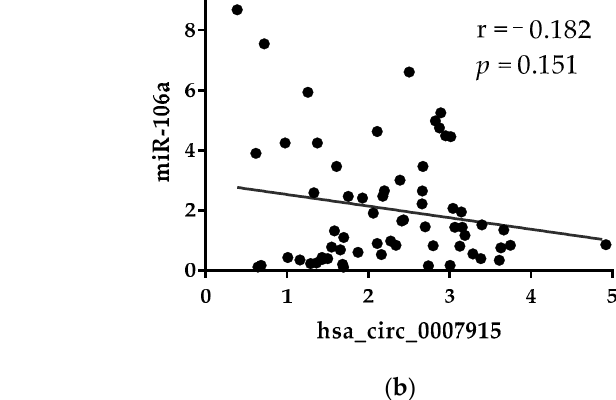
Figure 6. ( a ) Correlation between the expression levels of miR-181b and hsa_circ_0001445 in plasma of CRC in stage IV. ( b ) Correlation between expression levels of miR106a and hsa_circ_0007915 in plasma of CRC in stage IV. Spearman correlation was used to identify the correlation between the levels of miRNAs and circRNAs in plasma.